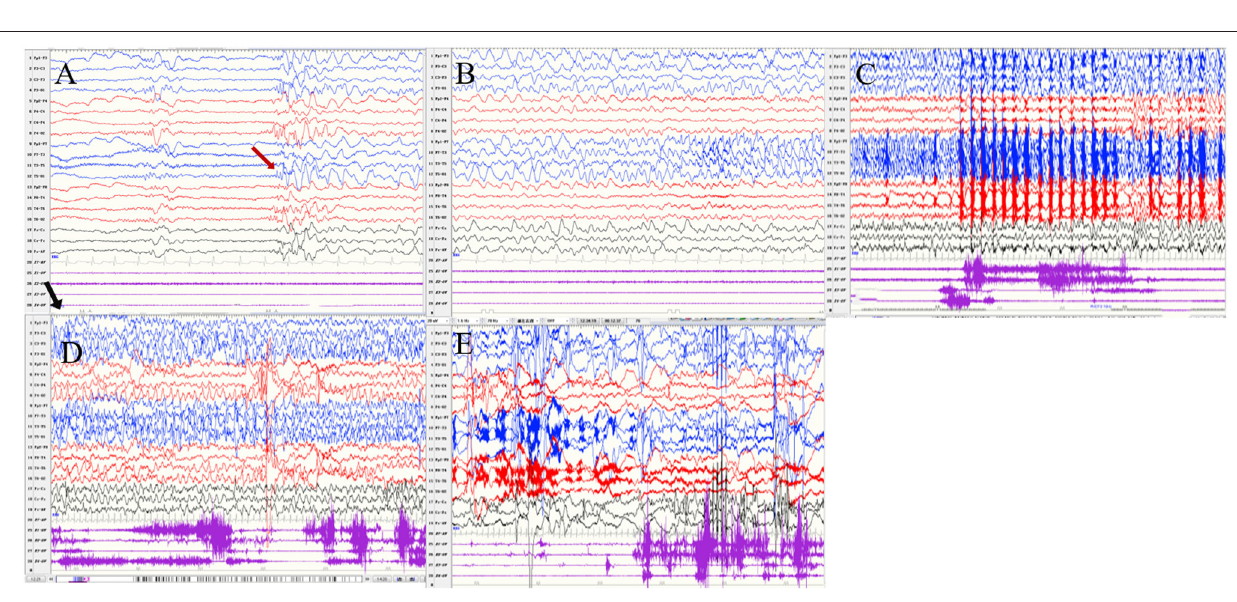
Frontiers in Neurology |